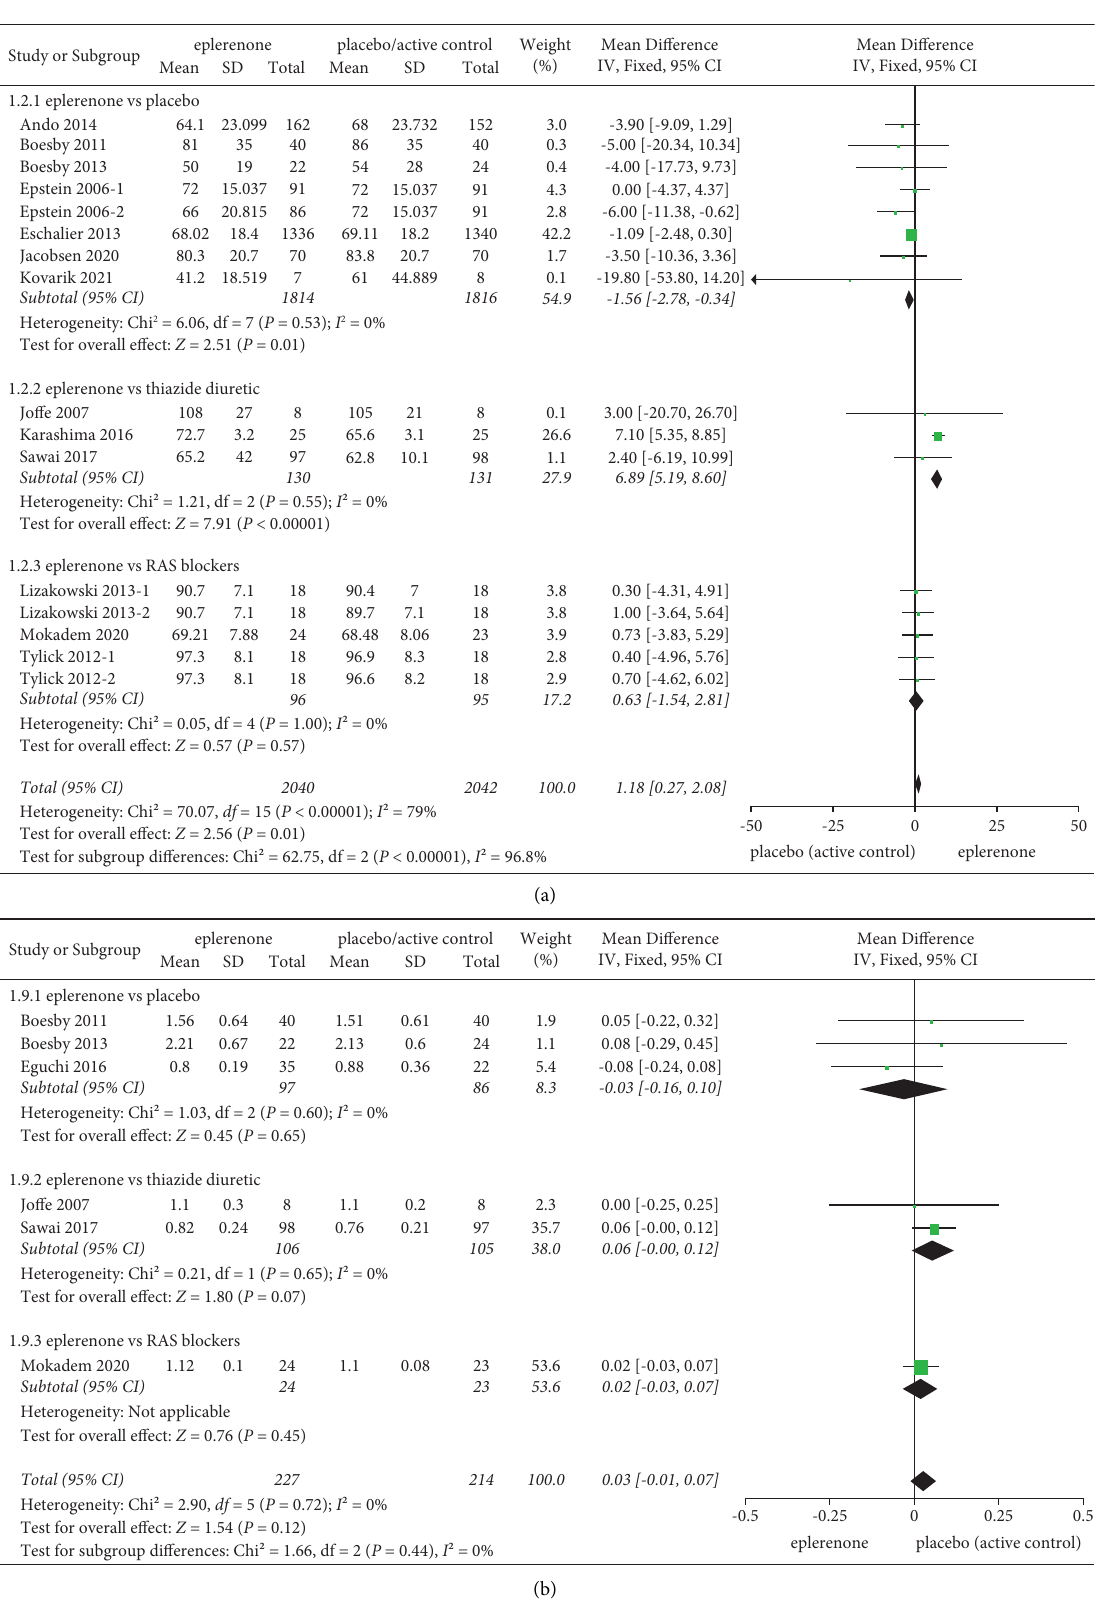
Figure 4: (a) Efect on eGFR in articles comparing eplerenone to placebo/active control. (b) Efect on serum creatinine for the eplerenone versus placebo/active control. Te black diamond indicates summary information with the center of the estimate pooled with the median diference, and the width covers the relevant 95%